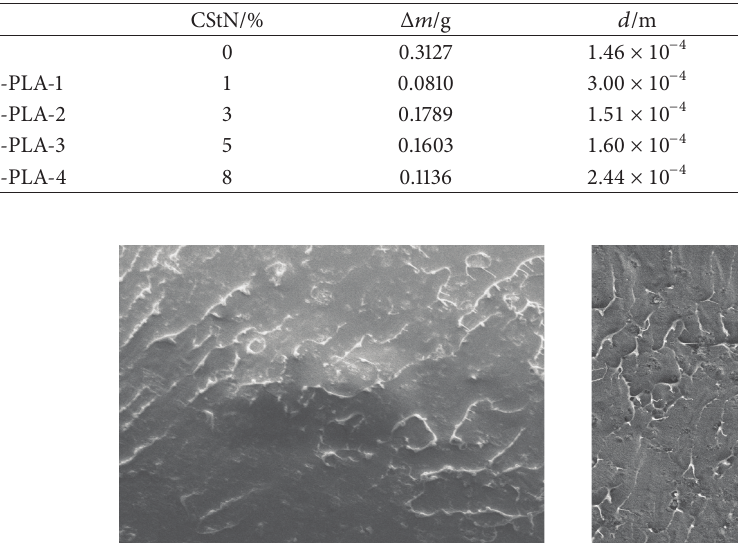
Table 1: Water vapor permeability of CStN/PLA nanocomposites and PLA films.